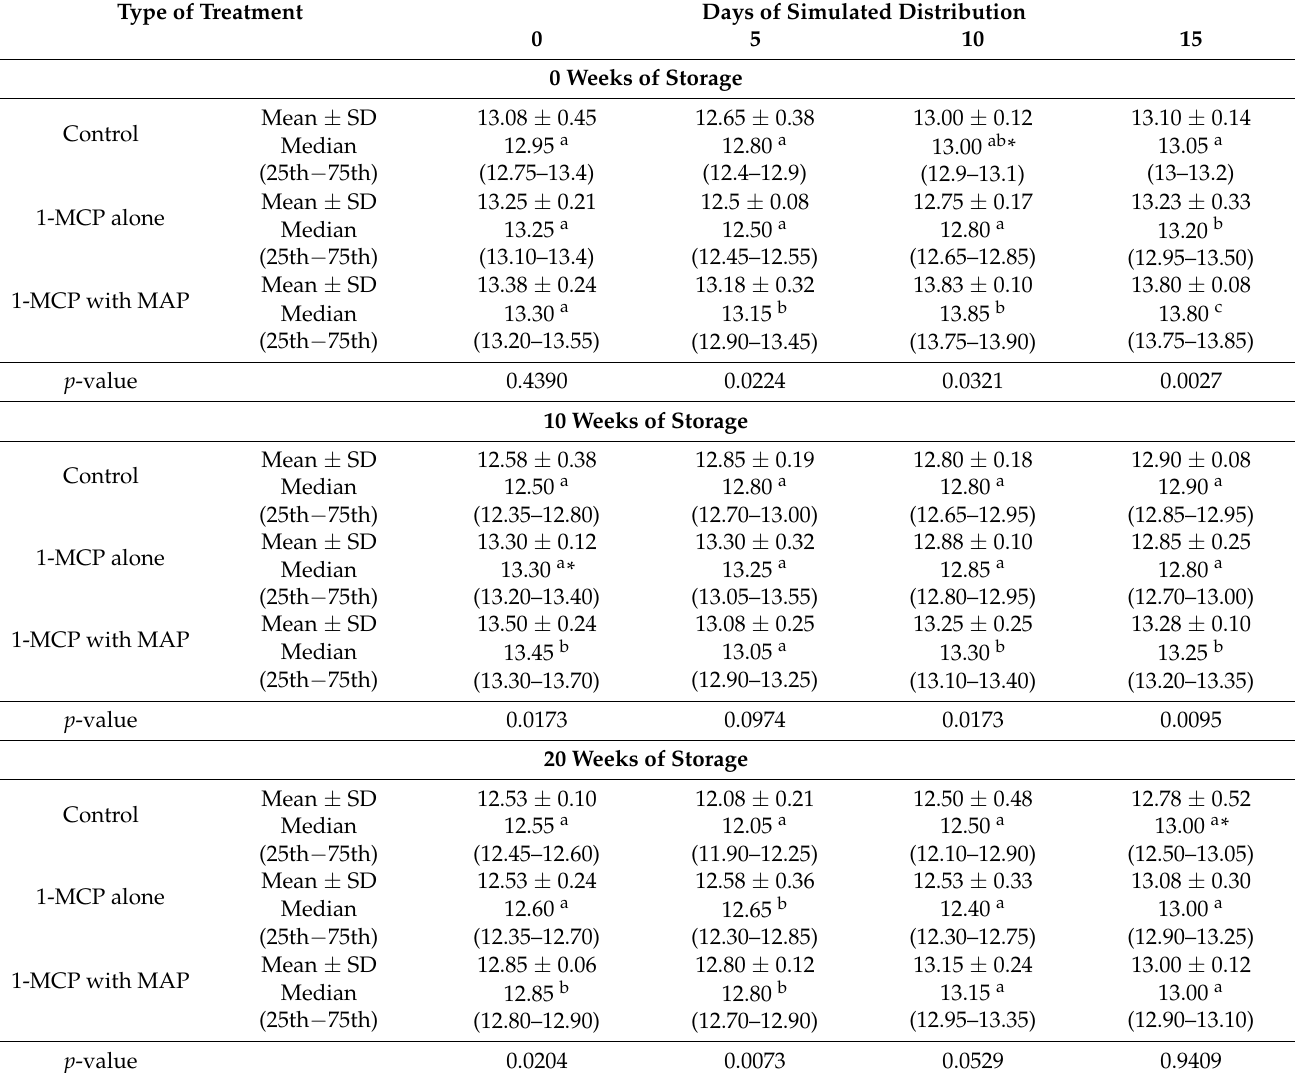
Table 3. The observed values of Total Soluble Solids content (TSS) ( ◦ Bx) for Idared apples after 8 weeks of simulated transportation, for the sub-groups subjected to various postharvest treatments, storage duration and duration of distribution. Type of Treatment